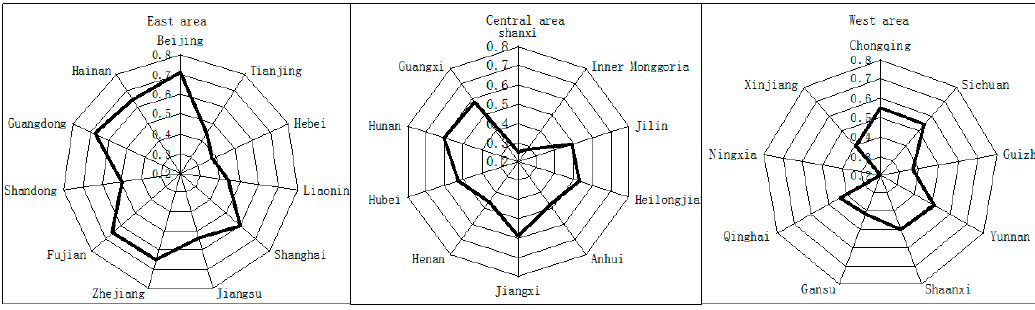
Figure 5. Map of drive sub-index in 2000 and 2015. The situation of the pressure sub-index generally indicates the north being gradually lower than the south, the west gradually lower than the east, and hopping in some areas as shown in (Figure 6), which is determined by various causes of development foundations, regional conditions and development policies in all regions. For quite a long time, the speed of economic development in